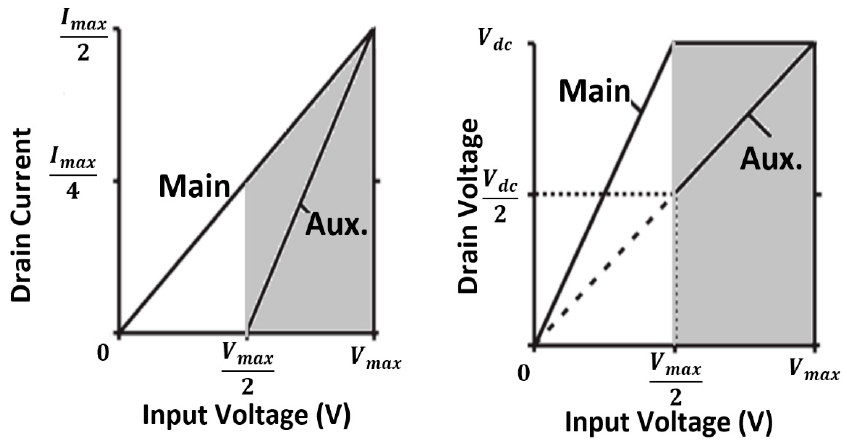
Figure 3. Voltage and current behavior of the Doherty amplifier [10].